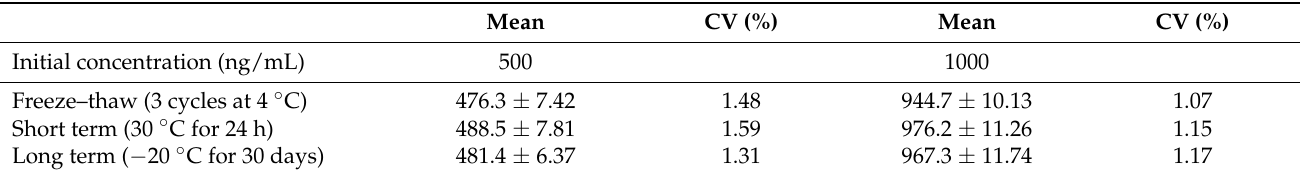
Table 8. Stability studies of ACV in